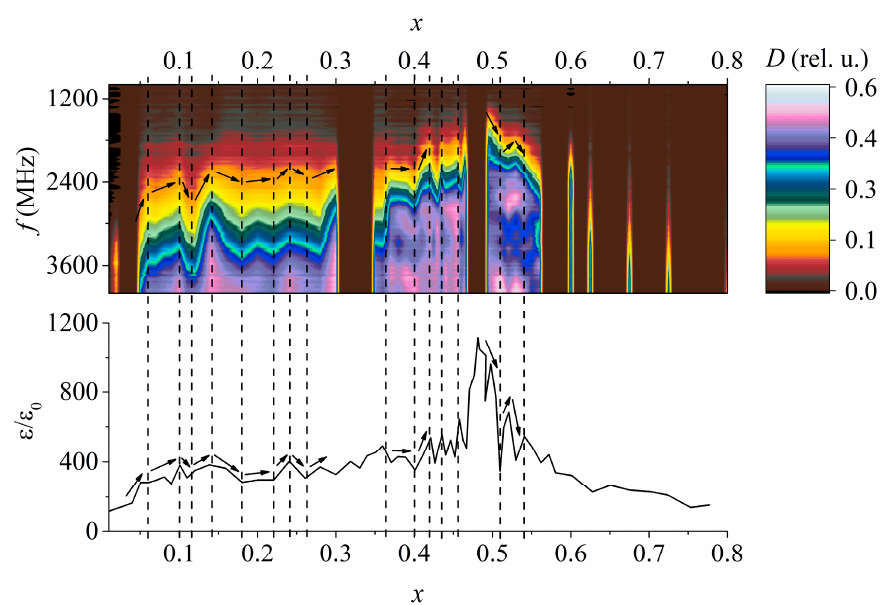
Figure 5. Comparison of the absorption coefficient spectrum ( D ) and the relative permittivity ( ε / ε 0 ) [15] dependences on the concentration of PT in PZT solid solutions. The dashed line shows the extreme values of the permittivity; the arrows show the trends for the absorption band to shift in frequency and changes in the permittivity. For a contrasting display of the absorption band, the drawing is made in a non-standard color scheme. Some SS samples were missing so there are gaps in the absorption coefficient diagram.